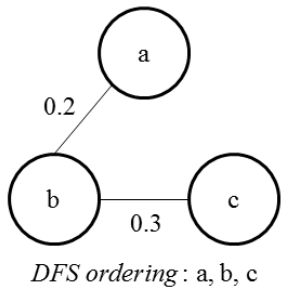
Figure 11. A correct band ordering given by DFS on MST